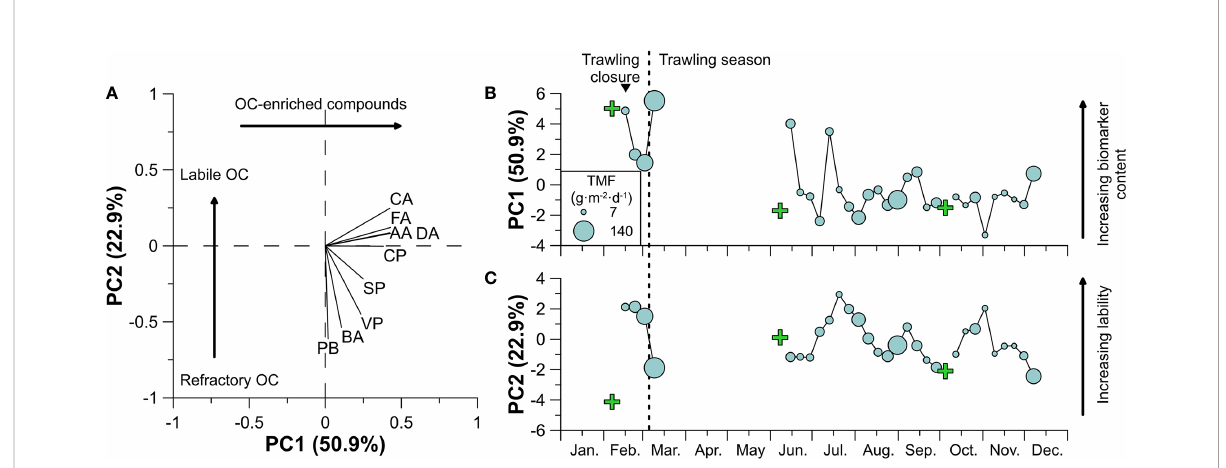
FIGURE 8 PCA results. (A) Eigenvalues of the PCA performed of OC-normalized CuO products in the sediment trap (Axis-1200). Temporal evolution of (B) PC1 and (C) PC2 values of the sediment trap samples, where the size of the circles refers to TMF and the green crosses show the PC value of sur fi cial sediment of the sediment core retrieved on the trawled fl ank in February, June, and October (Paradis et al., 2021b). The inverted triangle on top indicates the occurrence of a dense shelf water cascading